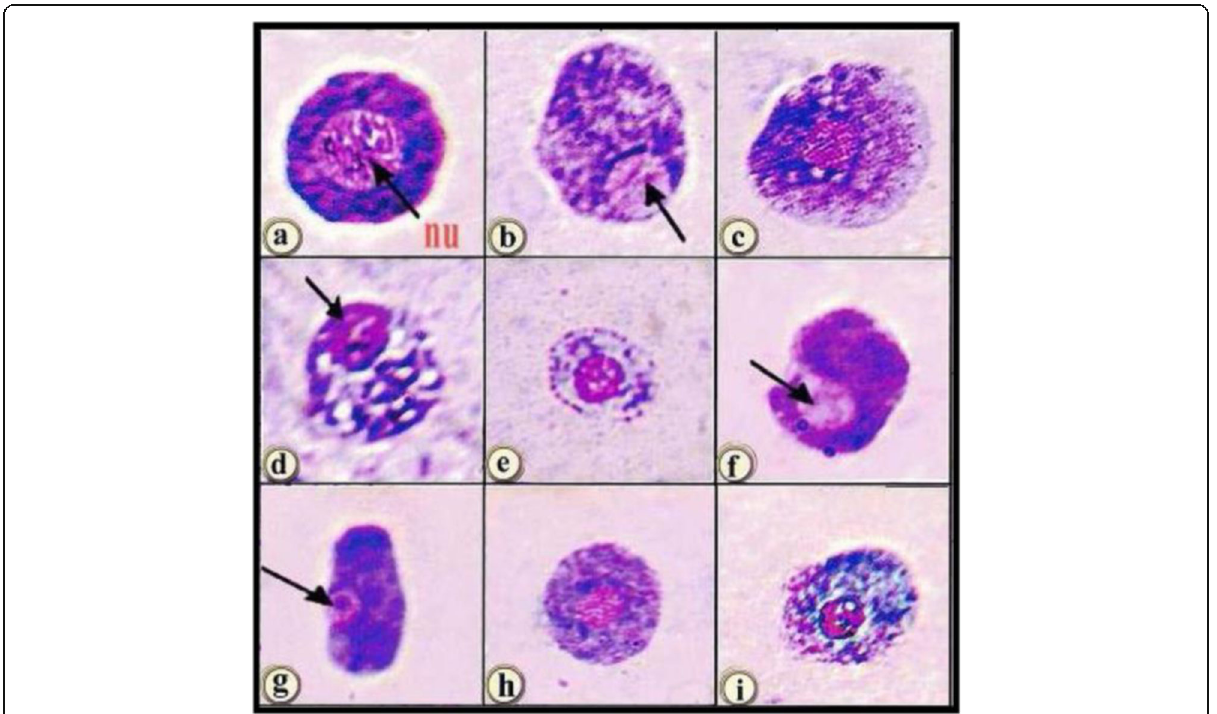
Fig. 3 Abnormalities in plasmatocytes ( x = 1600). a Normal: round with central nucleus plasmatocytes. b 40 Gy, c 100 Gy, and d BA2 20 IJs/ml: vacuolation of cytoplasm (arrow). e BA2 40 IJs/ml, f 40 Gy + BA2 20 IJs/ml, g 40 Gy + BA2 40 IJs/ml, h 100 Gy + BA2 20 IJs/ml, and i 100 Gy + BA2 40 IJs/ml: the cell takes an oval shape with acentric nucleus (arrow). nu indicates the hemocyte